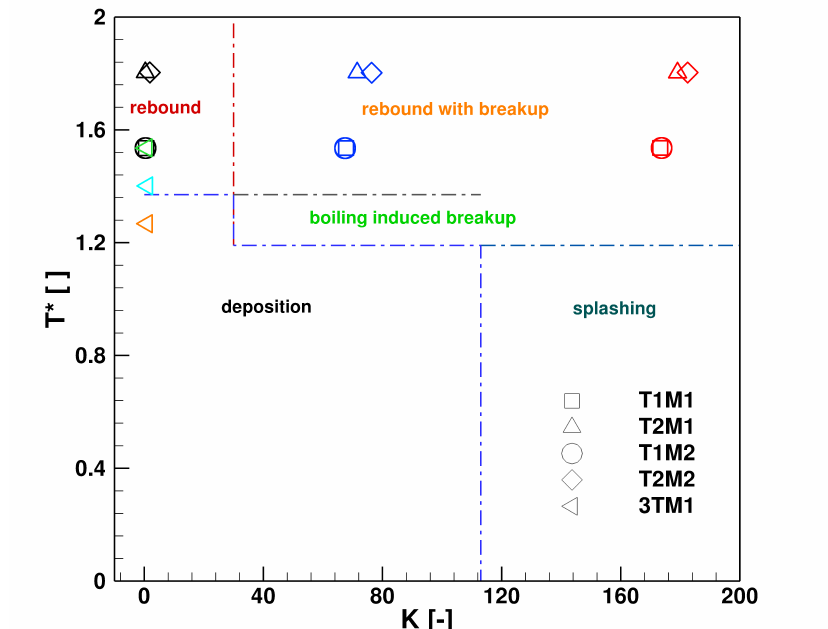
Figure 10. Droplet -wall impingement regime map [5,37] with operating points for single droplet study in cross flow (red: 200 µ m; blue: 100 µ m; black: 55 µ m; green: 573 K; cyan: 523K; orange: